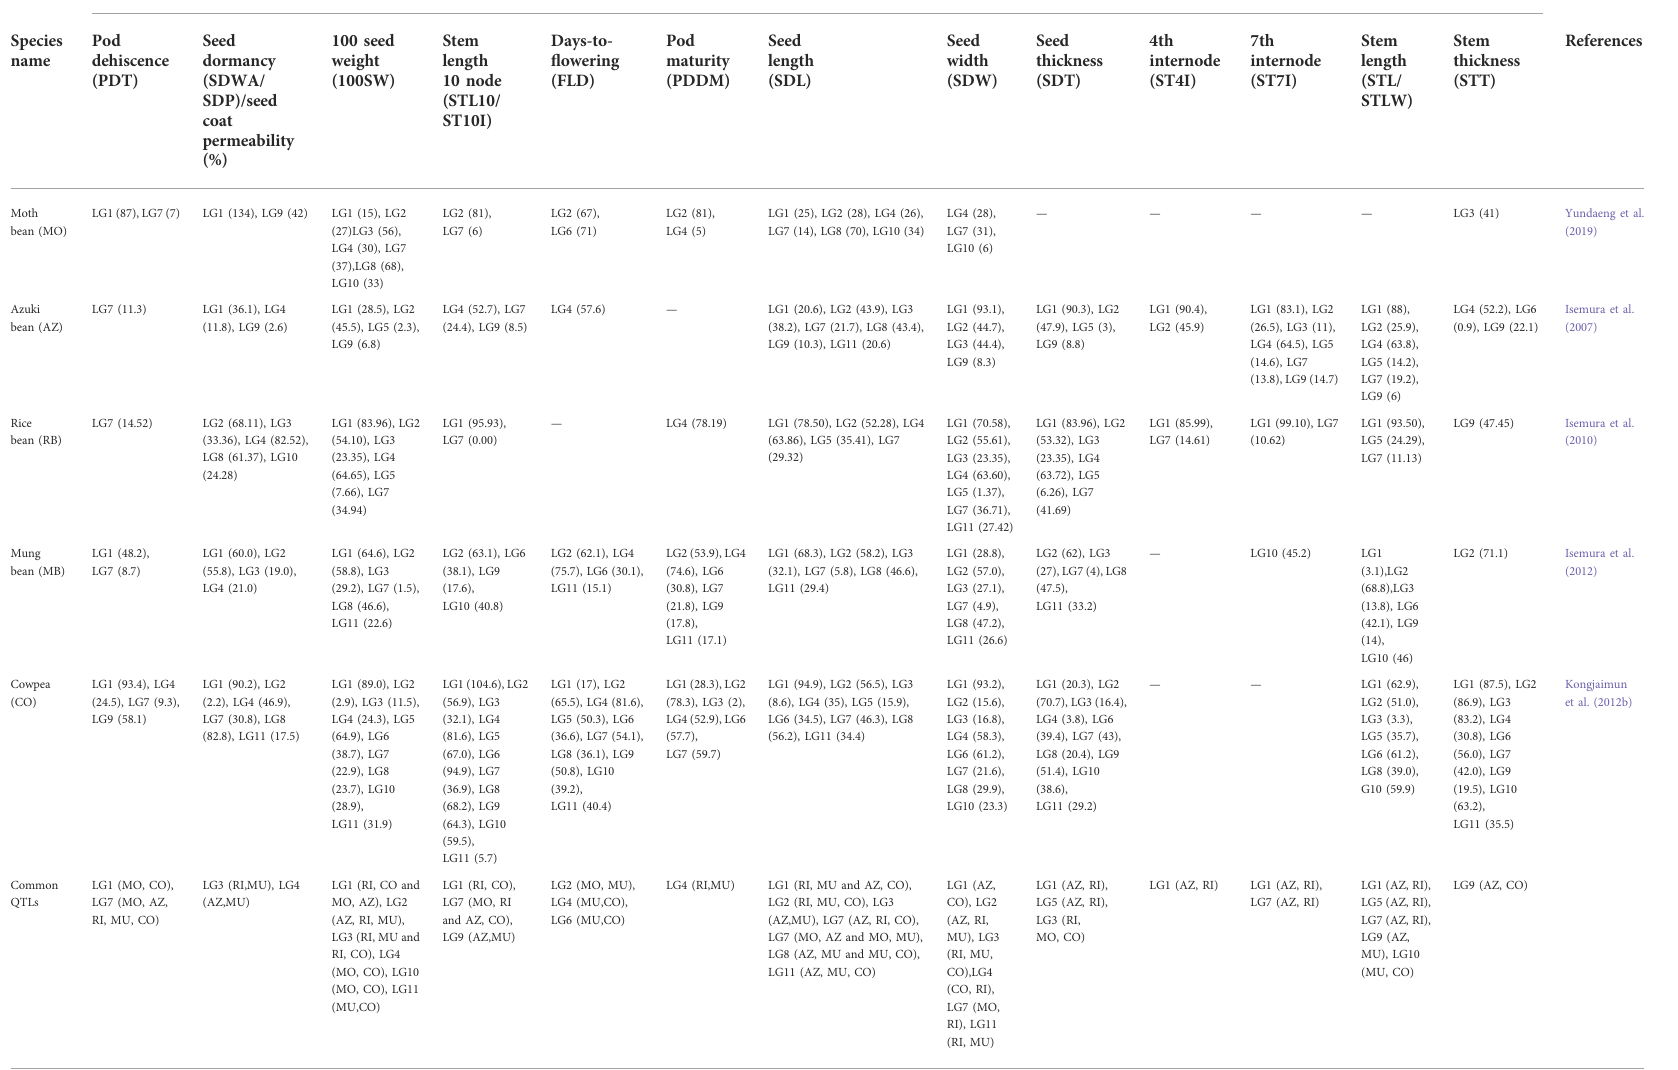
TABLE 1 Common major and minor DRT-associated QTLs detected in Vigna species. Domestication-related traits